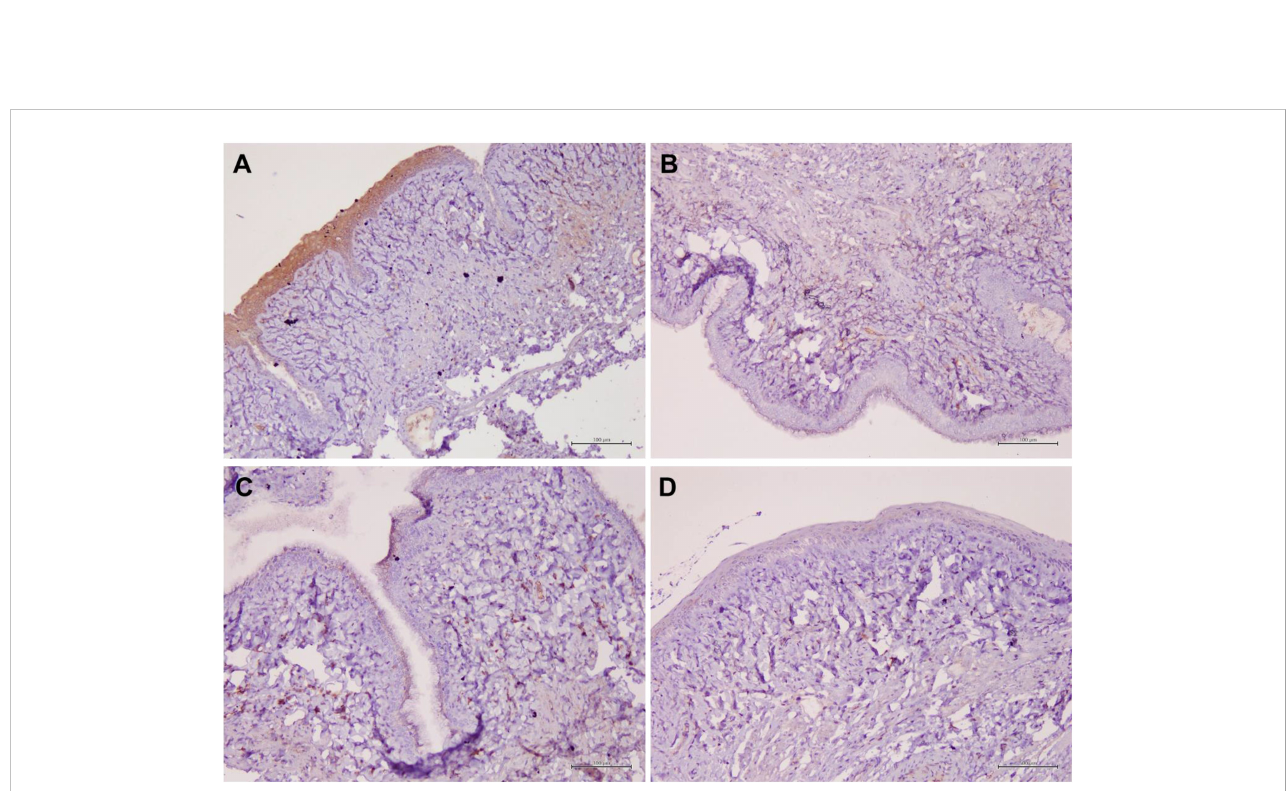
FIGURE 6 Structure of the rat vaginal epithelium and CFTR protein localization in the rat vaginal tissue following a two-week administration of Gelam honey at 0.2 g Gelam honey/kg bw/day doses. (A) Gelam honey and bilateral oophorectomized group (Gelam honey +Ovx), (B) Estrogen replacement therapy and bilateral oophorectomized group (ERT+Ovx), (C) Bilateral oophorectomized group (Ovx) and (D) Sham group (SC). The tissues were stained with DAB/ HRP stain for protein localization (in brown) and counterstained with H&E for nuclear staining. All measurement bars are equivalent to 100 µm.